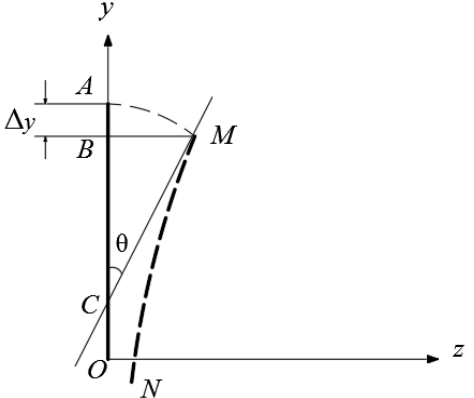
Figure 4. Scheme of differential body and computation of Δ y (x) .